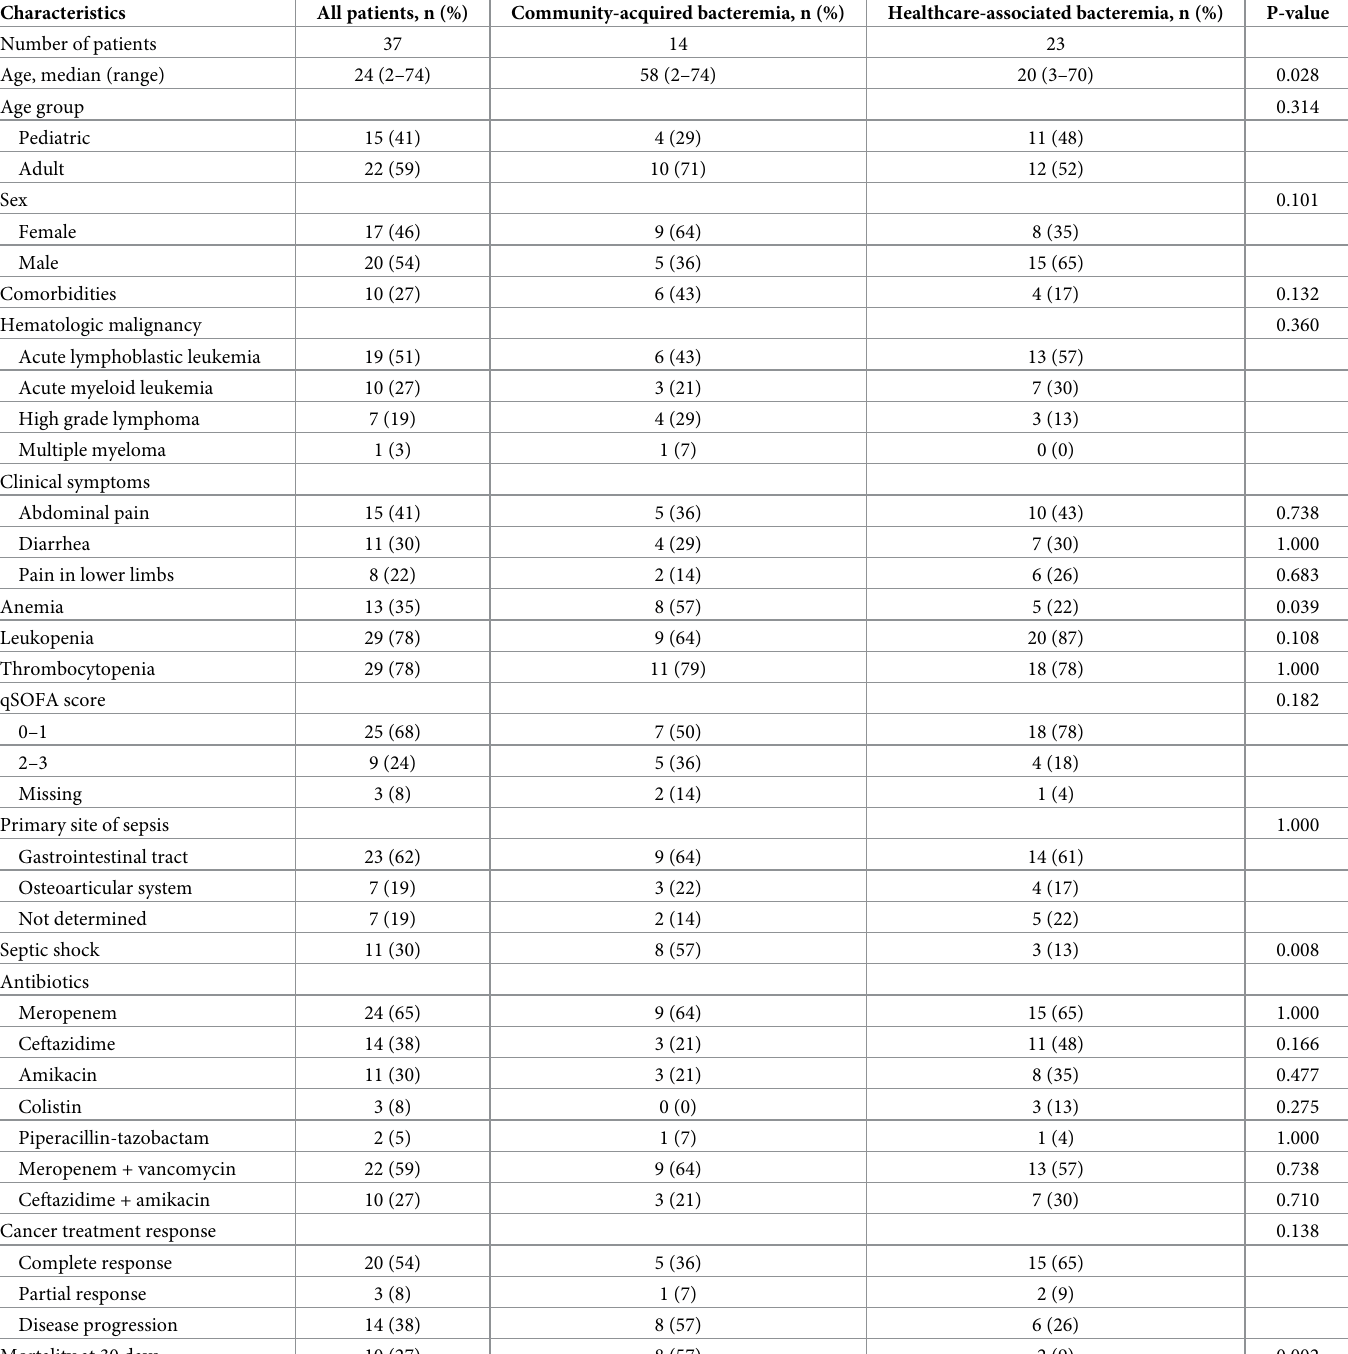
Table 1. Clinical characteristics of patients with hematological malignancies and Aeromonas sobria bacteremia according to the type of bacteremia.